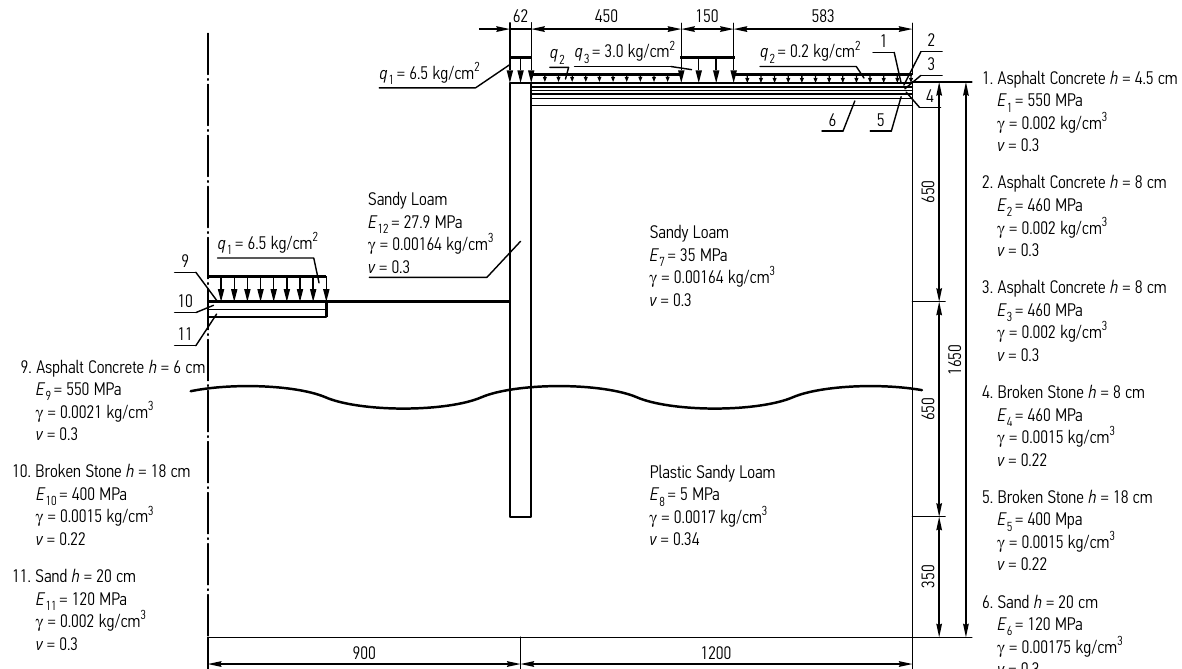
Fig. 2. The constructive scheme of the overpass retaining structures with the soil basis